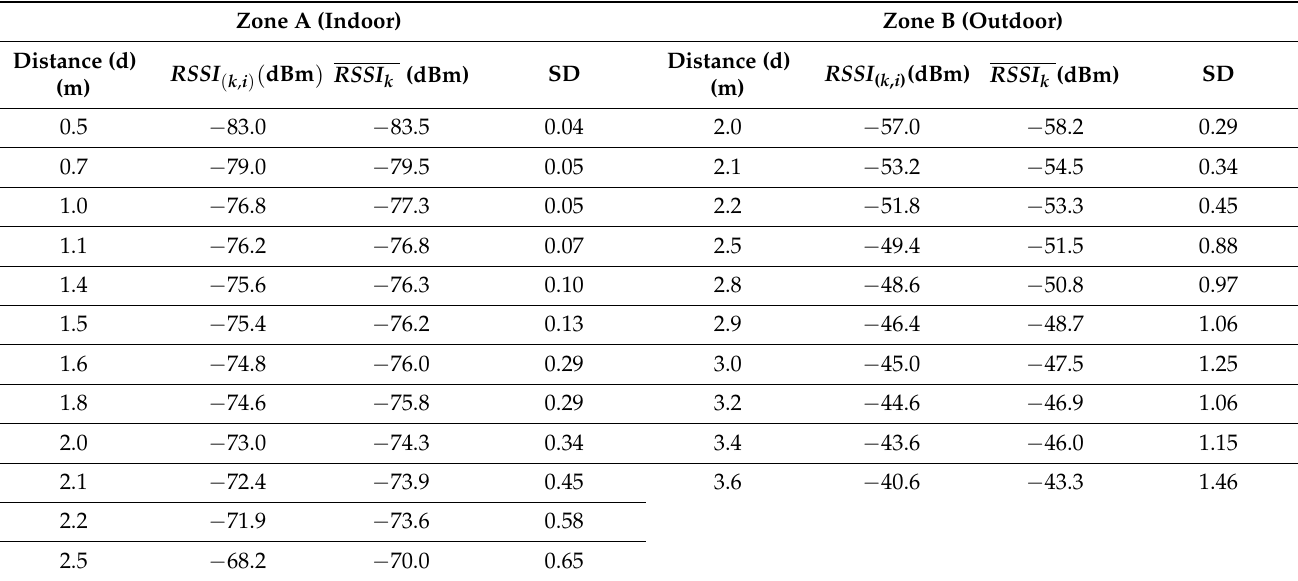
Table 2. Relationship of measured RSSI values and distance in each Zoning.